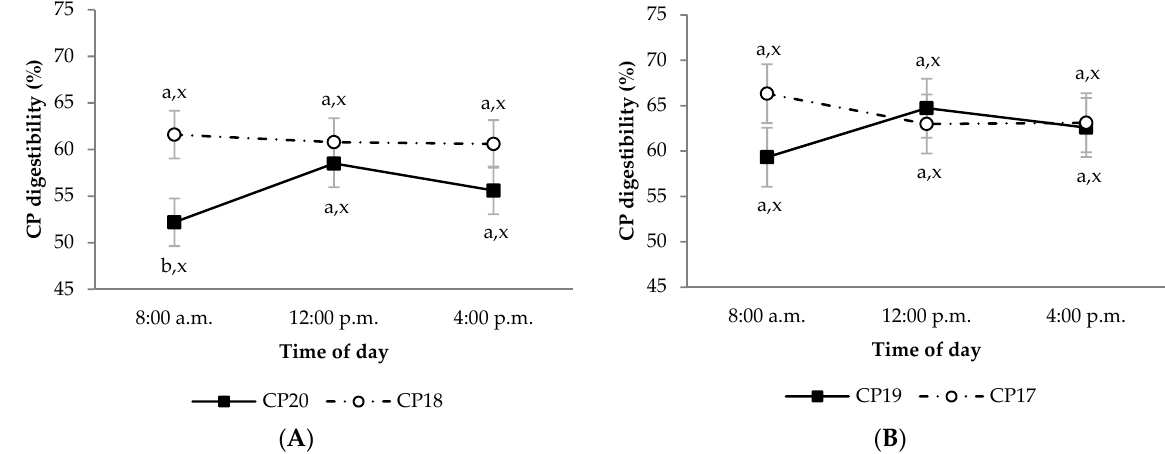
Figure 2. Digestibility of crude protein (CP) in growing ( A ) and finishing ( B ) periods in Ripollesa lambs fed with different concentrations of crude protein were compared between treatments (CP20 vs. CP18 and CP19 vs. CP17) and time of the day (least square mean values ± standard error). Within each sampling hour, different letters (a, b) denote statistical differences ( p ≤ 0.05) between dietary treatments. Within each dietary treatment, different letters (x, y) denote statistical differences ( p ≤ 0.05) between sampling hours.